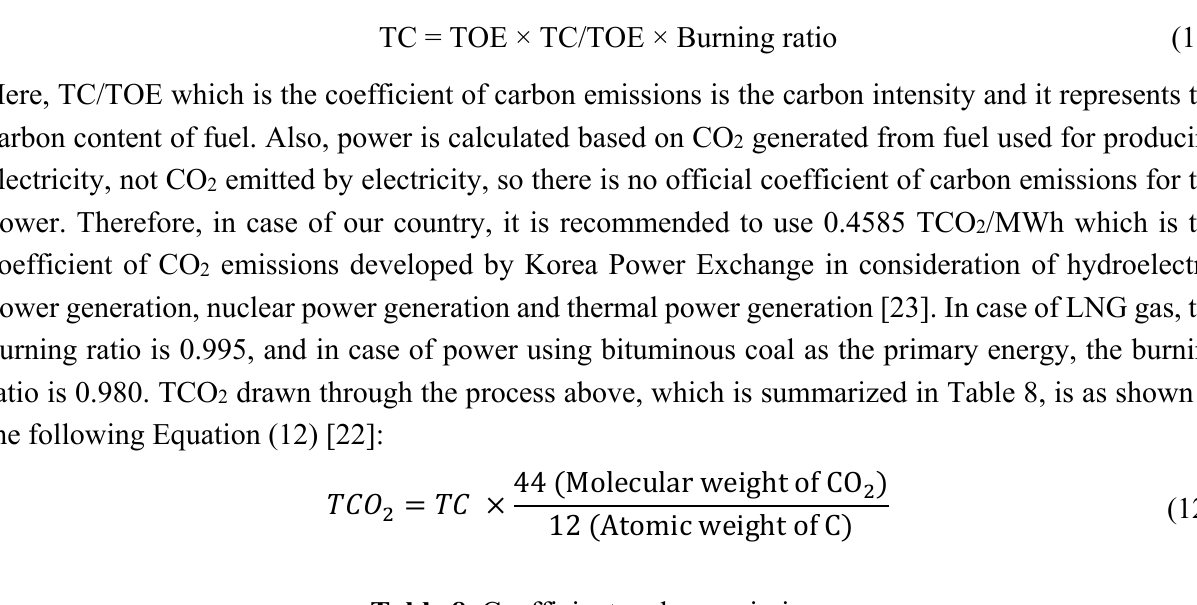
Table 8. Coefficient carbon